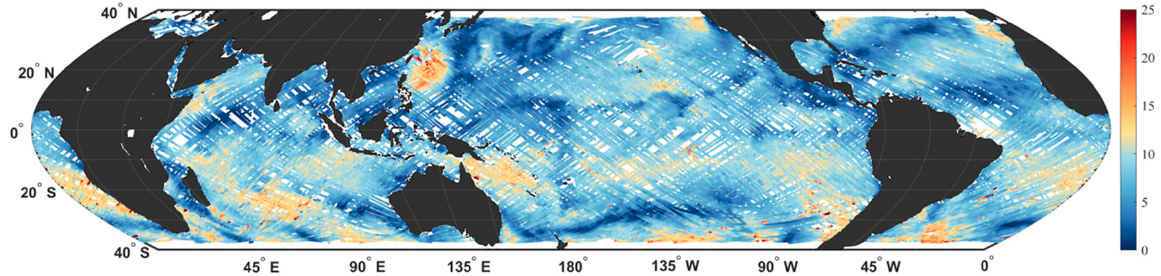
Figure 4. Full day of wind speed observations (m/s) on 30 August 2020 from the NOAA CYGNSS L2 Science Wind Speed 25-km v1.1 product.